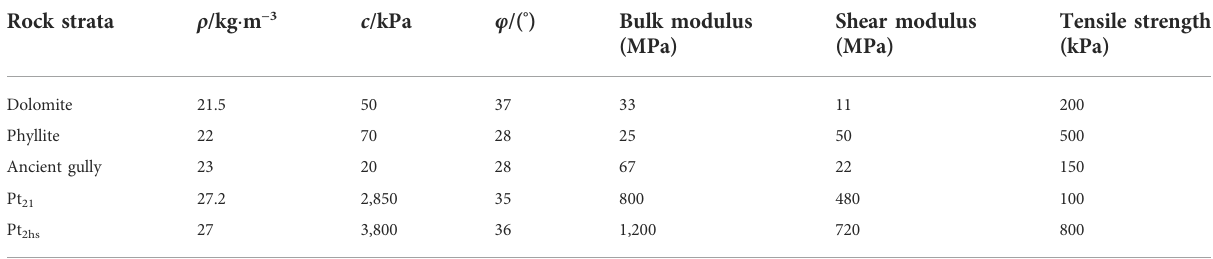
TABLE 2 Jinpingzi area II rock mechanical parameters.